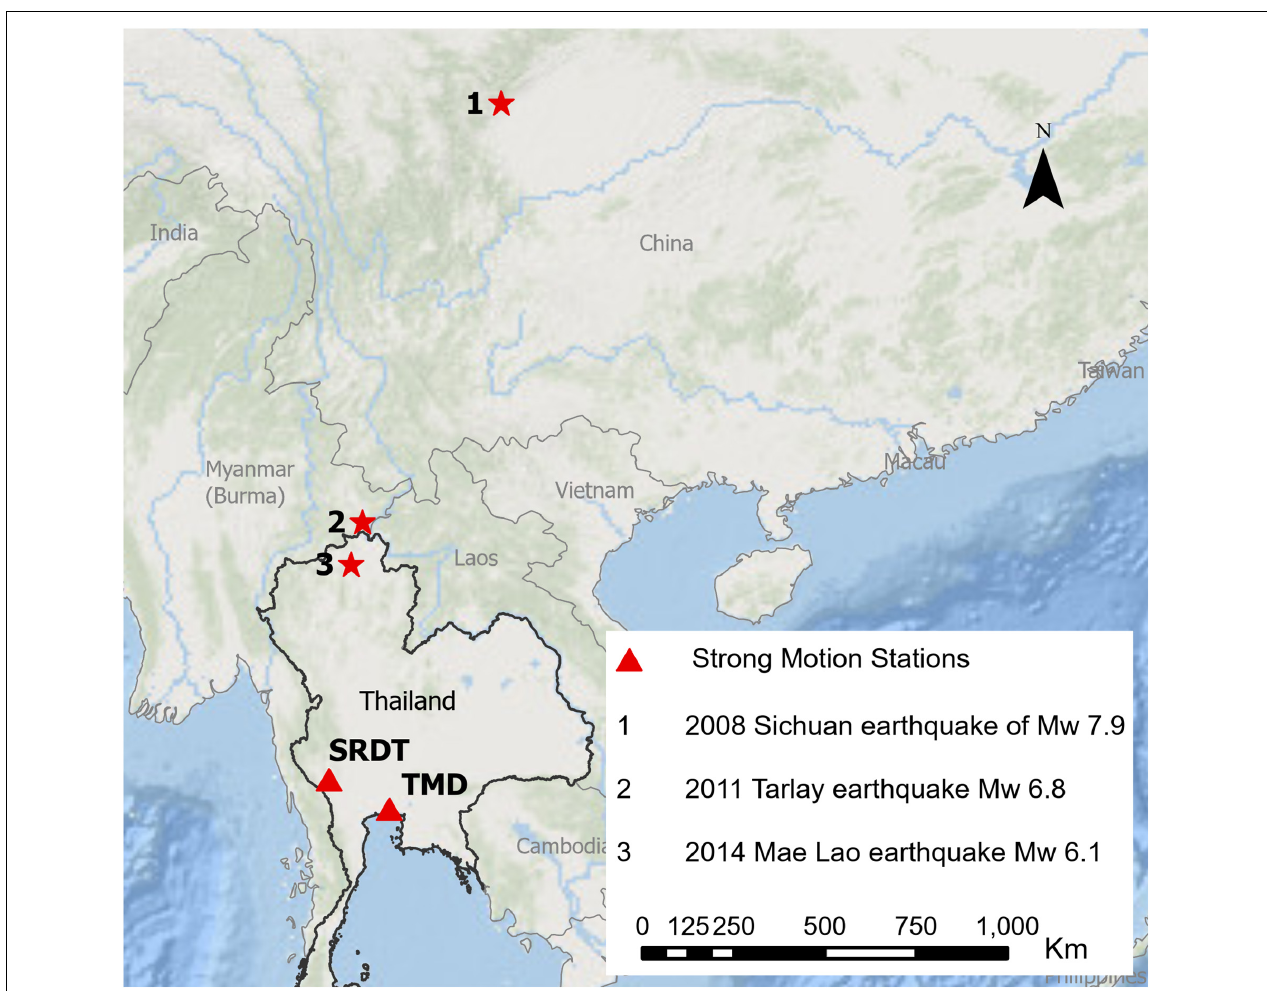
FIGURE 1 | Location of strong-motion stations TMD and SRDT with respect to the epicenter of the 2008 Sichuan Earthquake, 2011 Tarlay (Myanmar) earthquake and 2014 Mae Lao (Thailand)